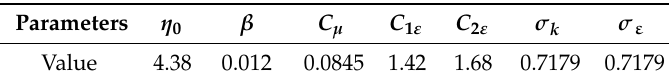
Table 1. Constants of k - ε equations.